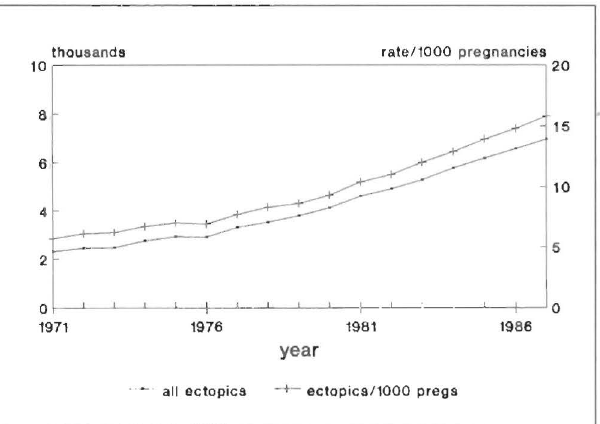
Figure 2) Ectopic pregnancies in Canada. nwnber and rate per total pregnancies. 197 1-8 7. (Source: Division qf STD Control. LCOC. Health and Weljare Canada) C AN J INFECT DIS V OL 2 SUPPL A A UGUST 199